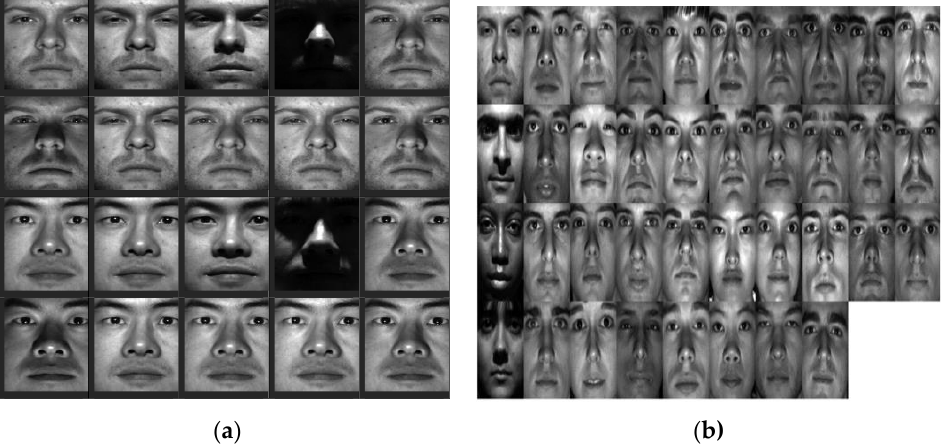
Figure 2. Sample images from the Extended Yale-B database ( a ) through two poses ( b ) from all poses.